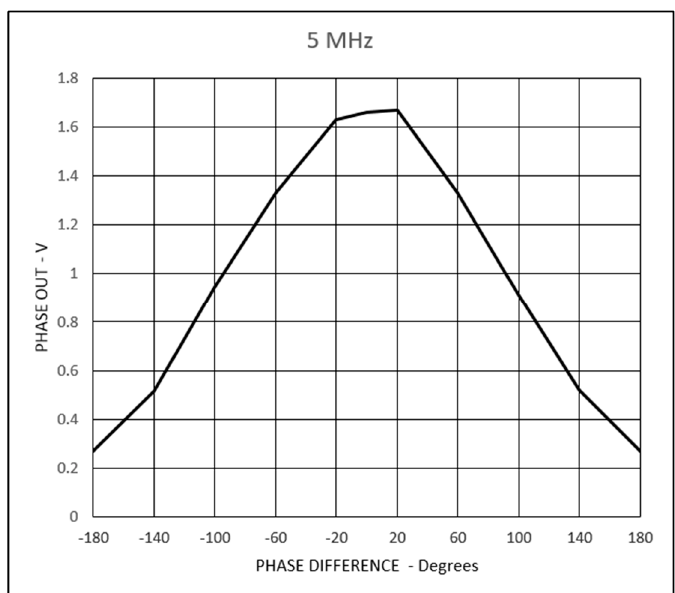
Figure 8. Phase Output vs. Input Phase Difference using the same parameters for the experiment.